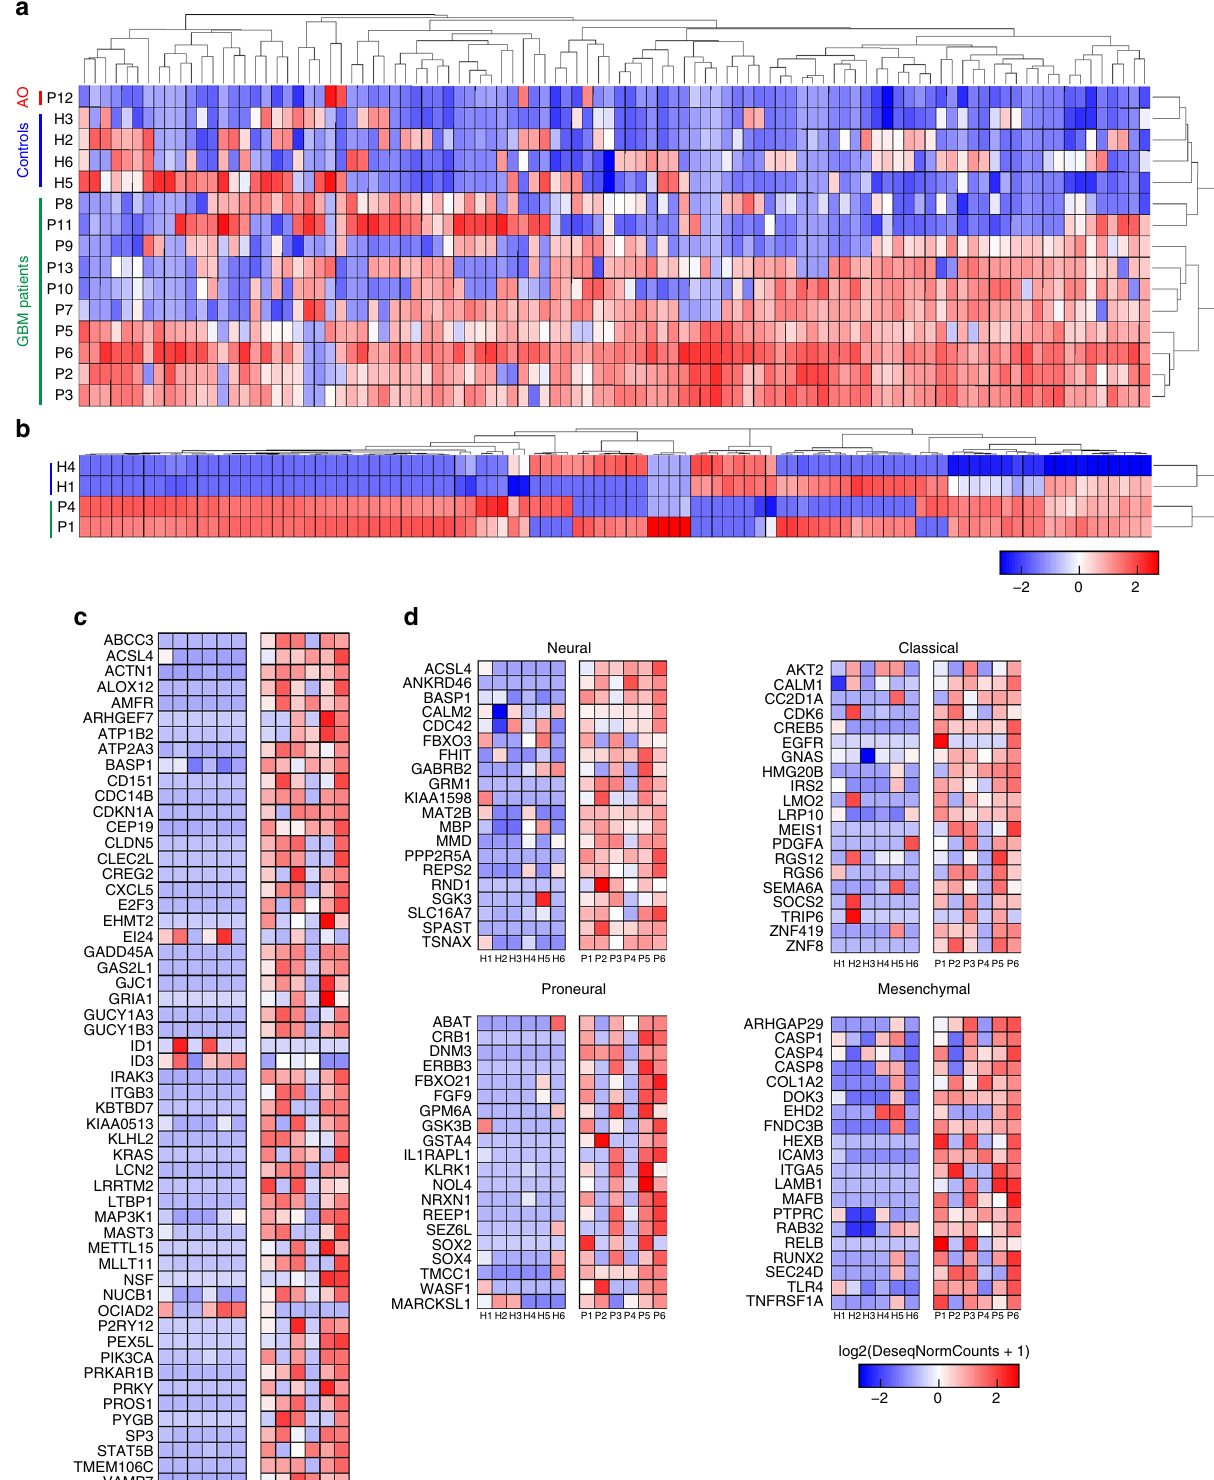
Fig. 4 RNA sequencing of EVs isolated using the EV HB-Chip. Unsupervised clustering of the 100 most variant genes identi fi ed in the EVs of patients and healthy donors using the EV HB-Chip. For plasma ( a ), data show 10 GBM patients clustering together with one patient clustering outside the group, Patient 12, which was later determined to be an anaplastic oligodendroglioma tumor (AO). For serum ( b ) GBM patients clustered together and separated from healthy donors. c Expression heatmaps of log2 normalized gene counts of 54 annotated enriched GBM genes and d 20 genes of each GBM subtype classi fi cation in patients compared to healthy donors ( n = 6 healthy donors (H), n = 13 patients